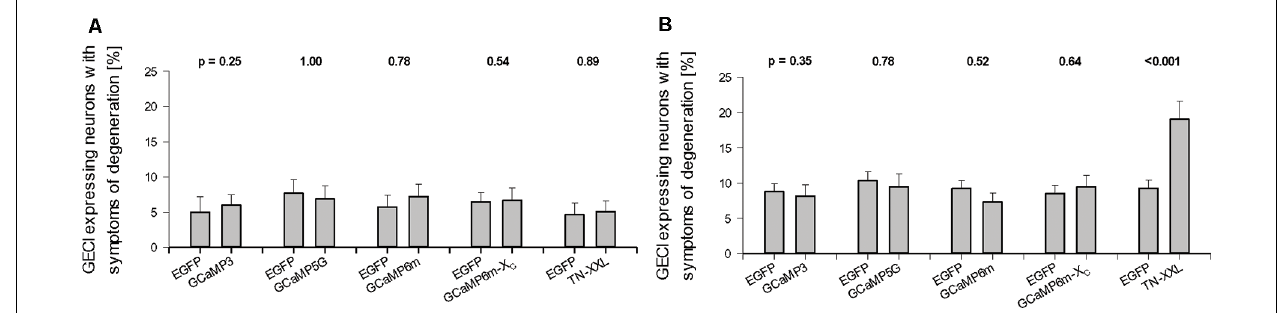
FIGURE 2 | Effect of prolonged genetically encoded calcium indicator (GECI) expression on neuronal degeneration. (A) DIV 14. (B) DIV 22–25. Percentages of GECI expressing neurons (mean ± SEM) displaying symptoms of degeneration after 10 and >16 days of overexpression plotted against the batch-internal controls. Percentages vary from culture to culture, but none of the GECIs presented with higher a readout at DIV 14. Same at DIV 22–25, except for TN-XXL transfectants which in all batches assessed displayed more transfectants with dendritic beading, shrunken somata, withering dendrites, or an entirely dissolved structure. In every culture, only the completely labeled neurons were scored as “healthy” or as displaying symptoms; in sum 100%. The numbers of assessed Organotypic cultures (OTCs) per condition and the number of culture batches are given in Supplementary Table S1 . The p values determined with the Mann–Whitney rank-sum test are given above each set of